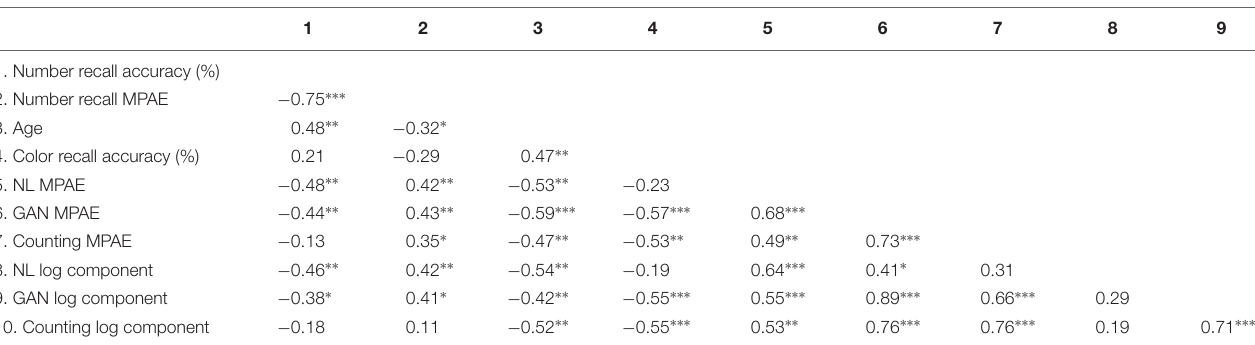
TABLE 2 | Correlations among numeric memory measures and predictor